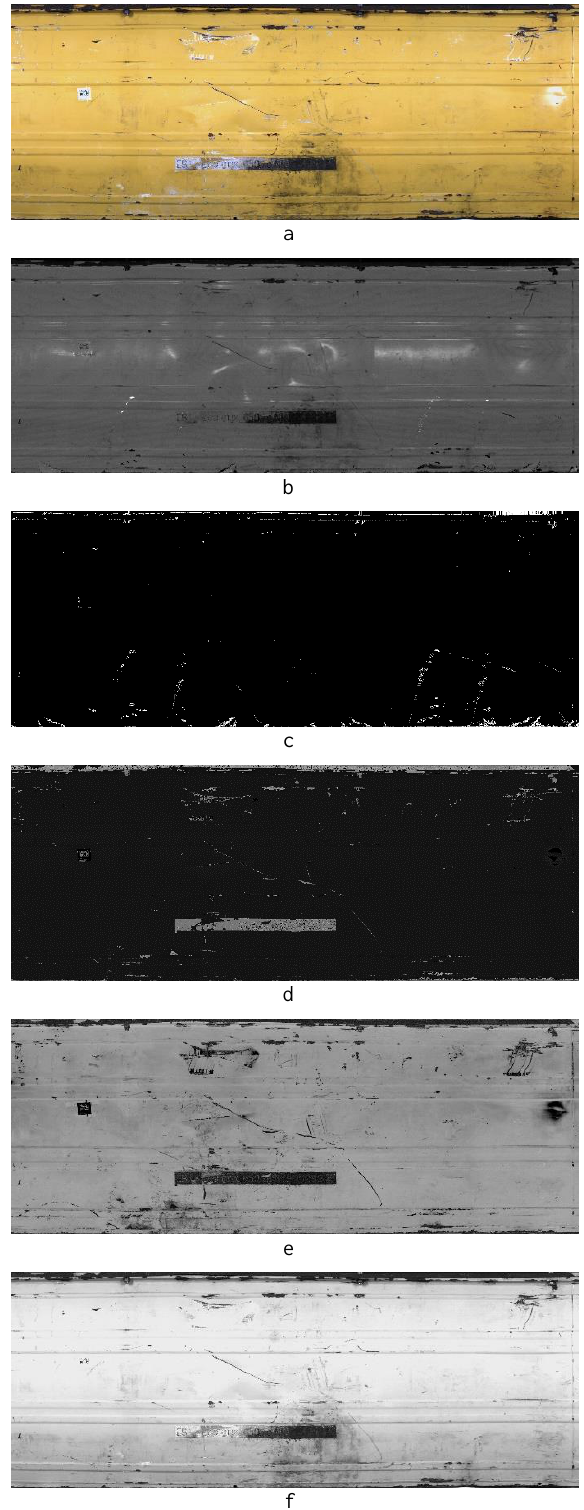
Figure 2. The eight utilized image channels: a) Three channels RGB, b) Range Intensity, c) Range derivative from sobel operation, d) HSI-Hue, e) HSI-Saturation, f)